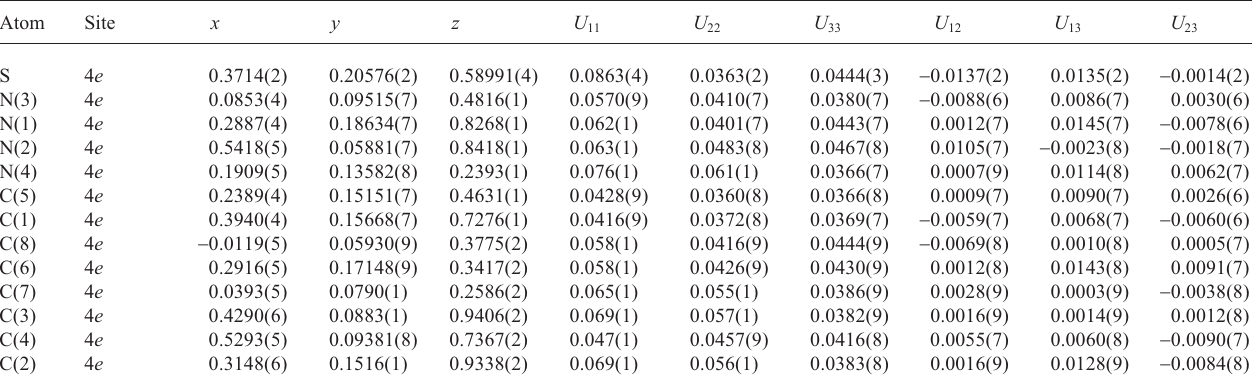
Table 3. Atomic coordinates and displacement parameters (in Å 2 )